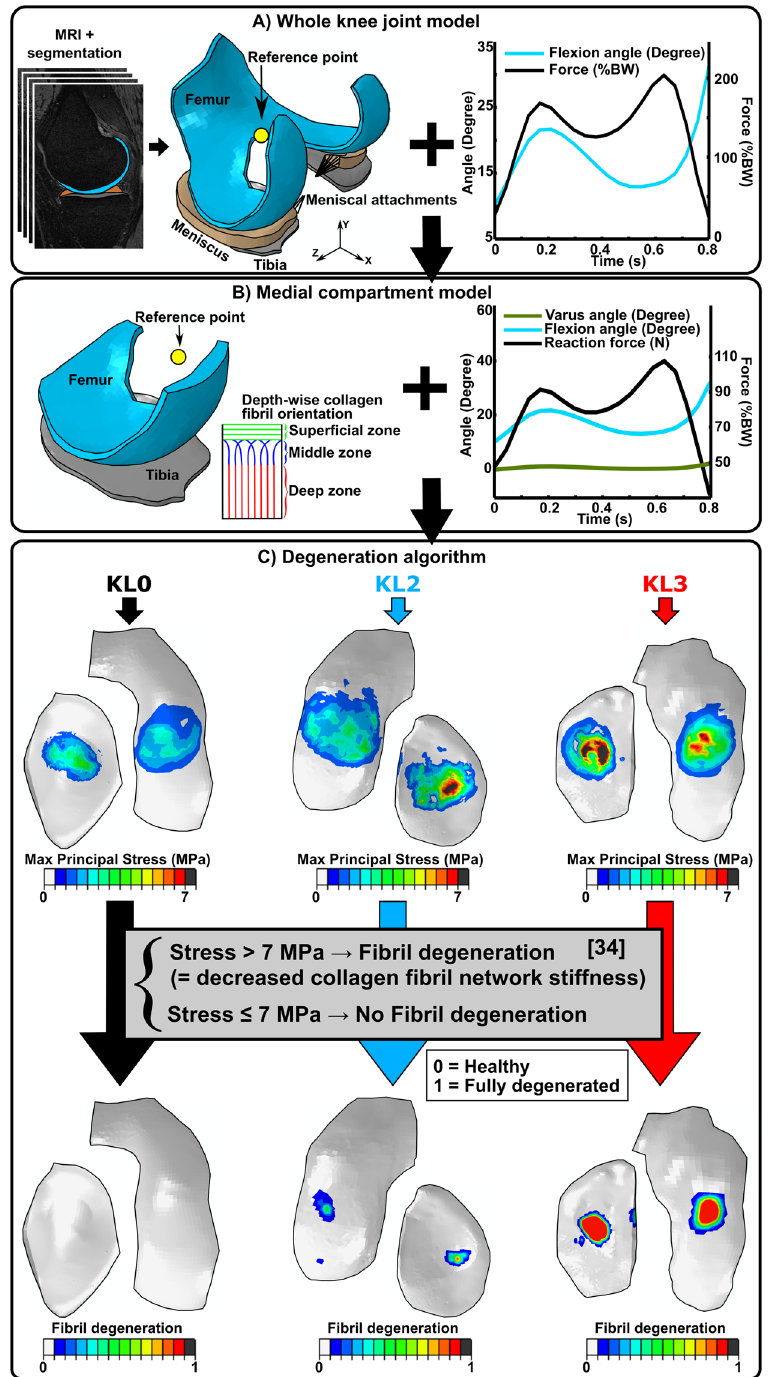
Figure 2. Method for predicting the level of knee osteoarthritis using cartilage degeneration algorithm. ( A ) Knee joints ( N = 21) were manually segmented from MRI images taken from OAI database and 3D geometries were created. Gait obtained from literature 63, 64 was implemented into the finite element models of the whole knee joint. ( B ) Medial compartment models were created to predict the level of medial knee OA (see justification behind that from Results section). Outcome force and rotations from the whole knee joint model were implemented into the compartment model to ensure similar knee joint motion in the compartment model as in the whole knee joint model. ( C ) Finally, cartilage degeneration algorithm was implemented into the medial compartment models to predict the level cartilage degeneration in three different KL groups (KL0, KL2 and KL3) after 100 iterations. In the algorithm, cartilage fibril degeneration occurs if tensile stress exceeds 7 MPa failure limit 34 , decreasing collagen fibril network stiffness (See more details in Method